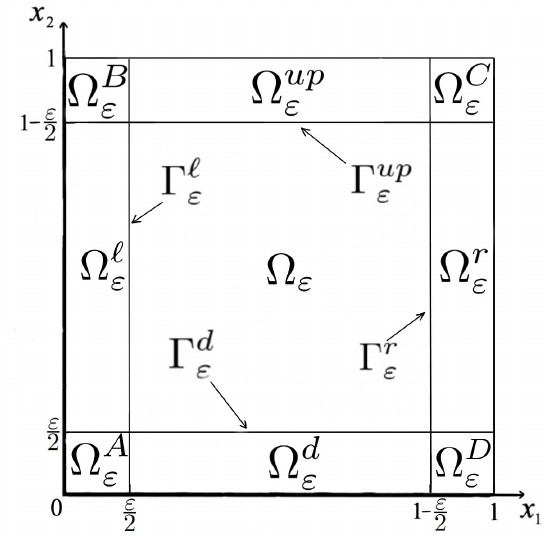
Figure 3. The sets Γ (cid:96) ε , Γ r ε , Γ d ε , Γ up ε and Ω (cid:96) ε , Ω r ε , Ω d ε , Ω up ε , Ω A ε , Ω B ε , Ω C ε , Ω D ε